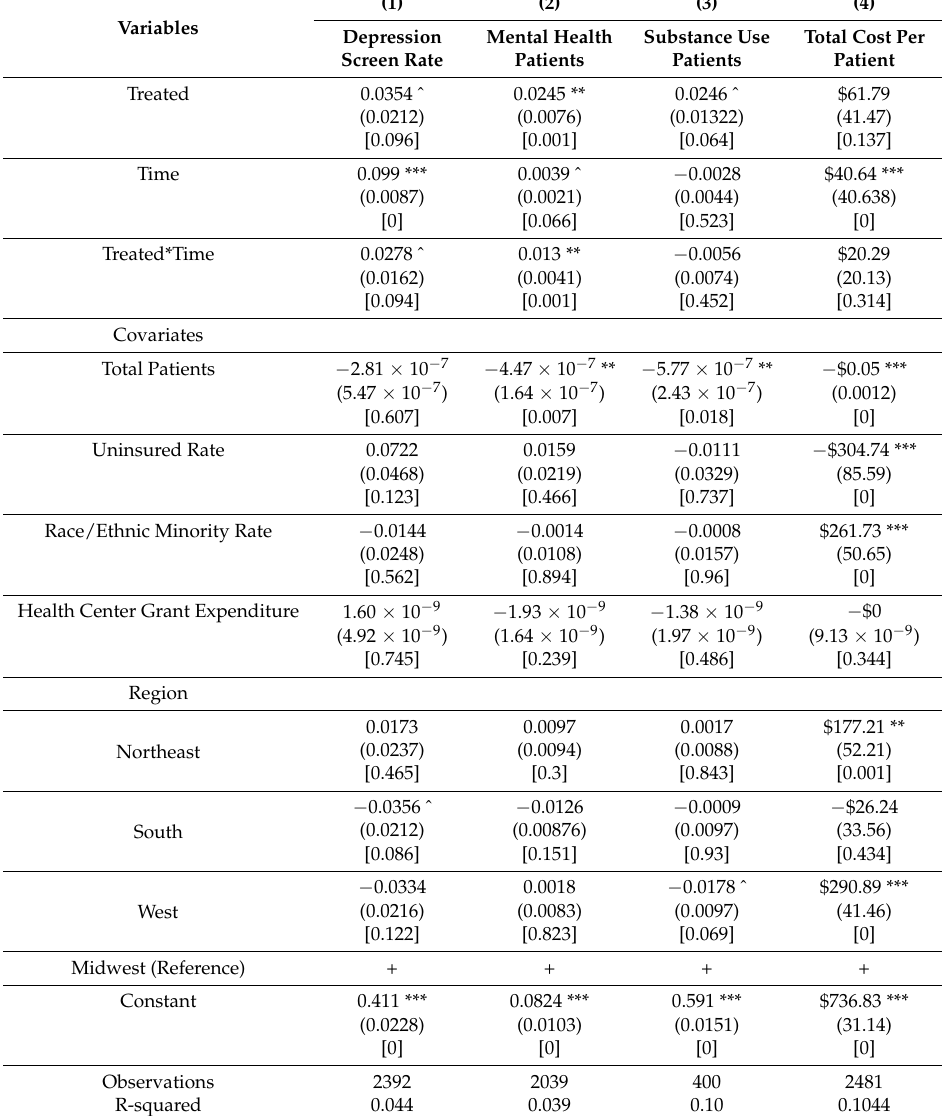
Table 3. Multivariate Regression Analysis: BHI Grantees vs. all Non-BHI-Grantee FQHC Comparison